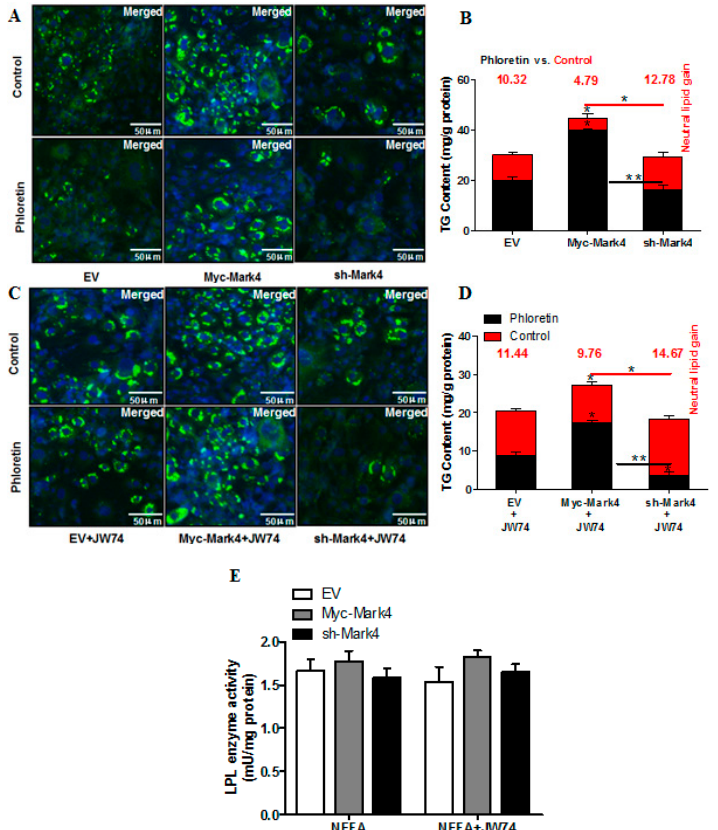
Figure 6. Activation of the WNT/ β -catenin pathway by MARK4 promotes lipid accumulation in pig primary trophoblast cells challenged with 400 µ M NEFA. ( A and C ) Representative images (100 × ) of Bodipy staining after transfection with Myc-MARK4, sh-MARK4 for 48 h in primary (trophoblast cells) isolated from pig placentas. Cells were then incubated with 400 µ M NEFA, 10 µ M JW74 or 500 µ M phloretin for 24 h ( n = 3). ( B and D ) Quantification of corresponding triglyceride (TG) in ( A ) and ( C ) by ELISA analysis ( n = 3). The values in red indicate receptor (transport proteins)-mediated fatty acid accumulation by subtracting the values in the presence of phloretin from those in the absence of phloretin. ( E ) LPL activity (mU/mg protein) after transfection with Myc-MARK4, sh-MARK4 for 48 h in pig primary trophoblasts. Cells were then treated with 400 µ M NEFA or 10 µ M JW74 for 24 h ( n = 3). Values are expressed as mean ± SEM. ** p < 0.01; * p < 0.05 compared with the control group.